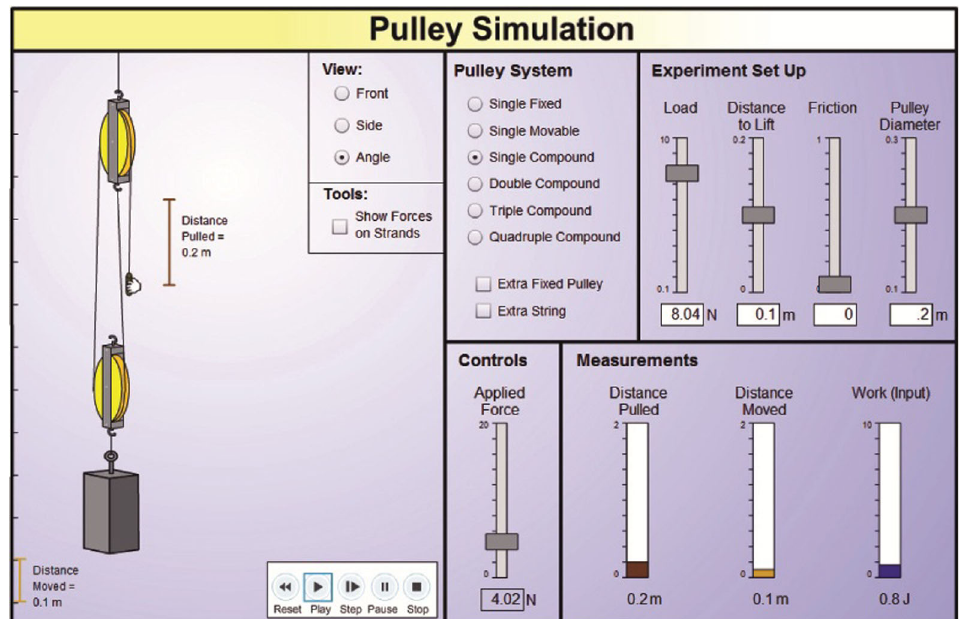
FIG. 3 (color online). The virtual manipulative for the pulley experiments was a computer simulation that allowed students to select a pulley system, set the load and distance lifted, apply an input force, and observe the distance the string was pulled and the work required to lift the load.